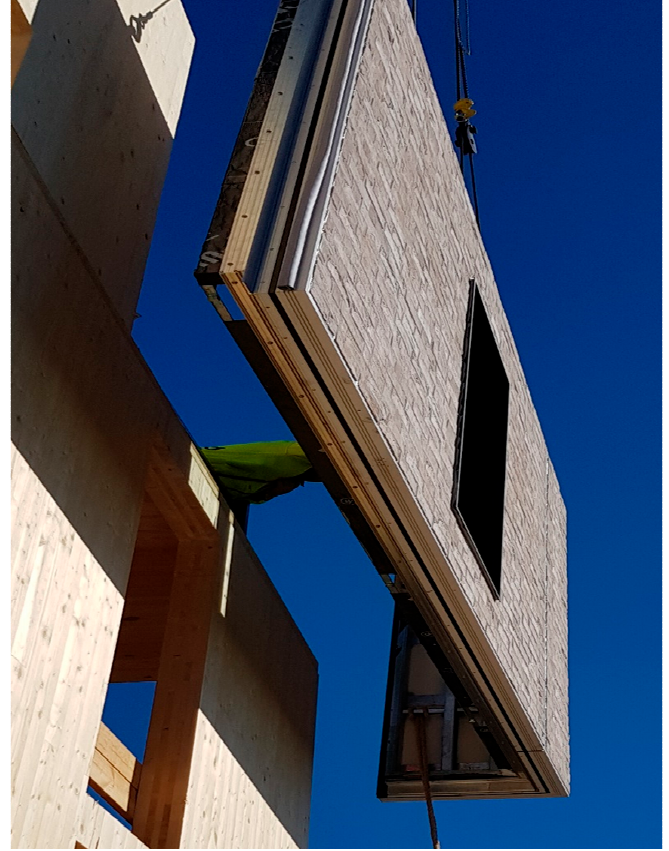
Figure 1. Lifting of a prefabricated façade masonry walling system.